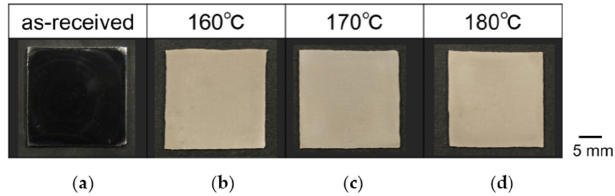
Figure 2. Appearance of ( a ) uncoated specimen and specimens subjected to steam coating at ( b ) 160 °C, ( c ) 170 °C, and ( d ) 180 °C for 1 h.